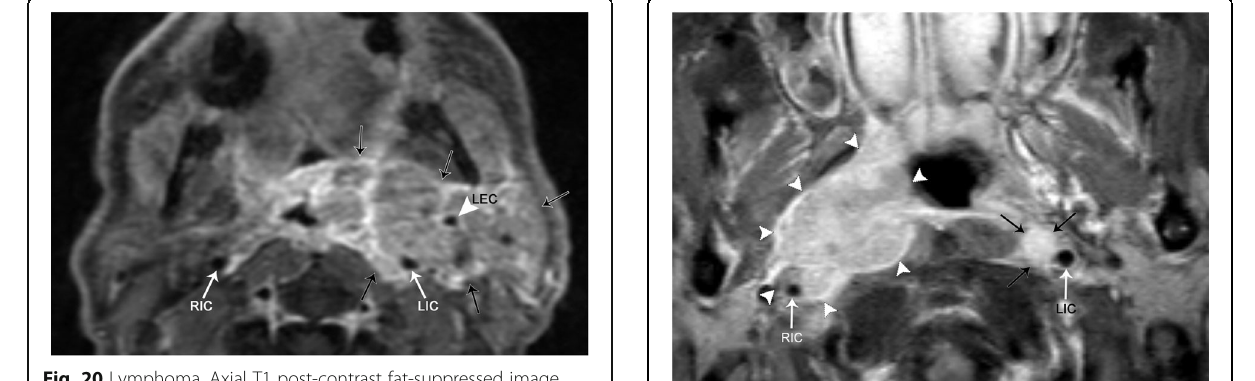
Fig. 20 Lymphoma. Axial T1 post-contrast fat-suppressed image demonstrates a conglomerate of heterogeneously enhancing masses that completely encase the left internal (LIC) and external (LEC) carotid arteries. Note that the lumen of the LIC is similar in caliber to the right internal carotid artery (RIC)